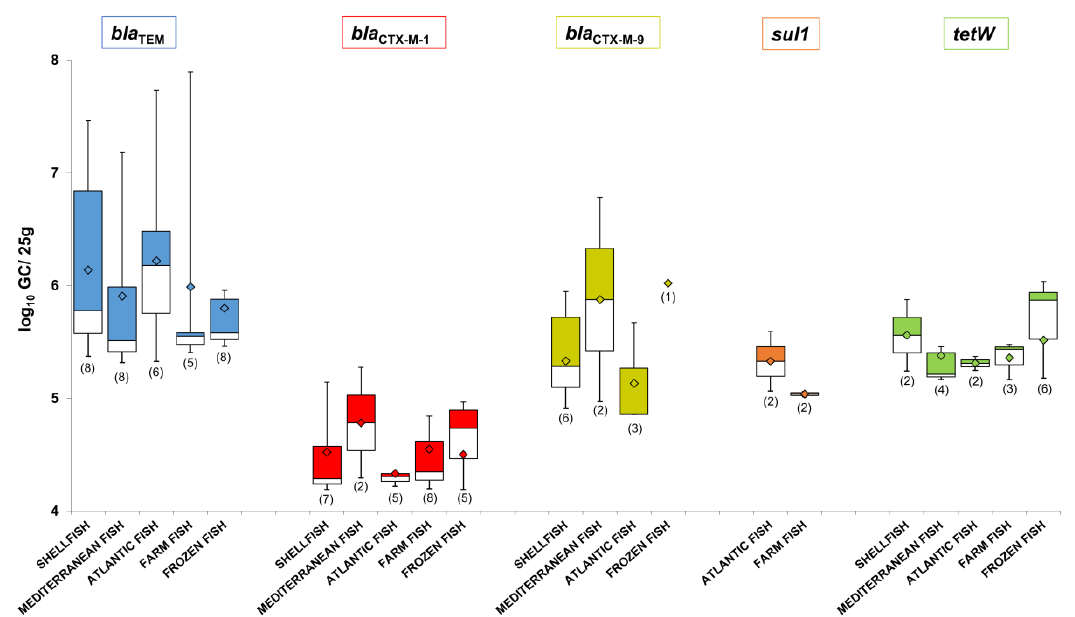
Figure 5. Abundance of ARGs in the DNA isolated from the phage particles of each fish matrix and shellfish (log 10 GC / 25 g) grouped by ARG. Data is represented in boxplots; the diamond represents the average value of the positive samples, the upper squares include samples whose values are within the 75th percentile, and those in the lower white boxes are within the 25th percentile.